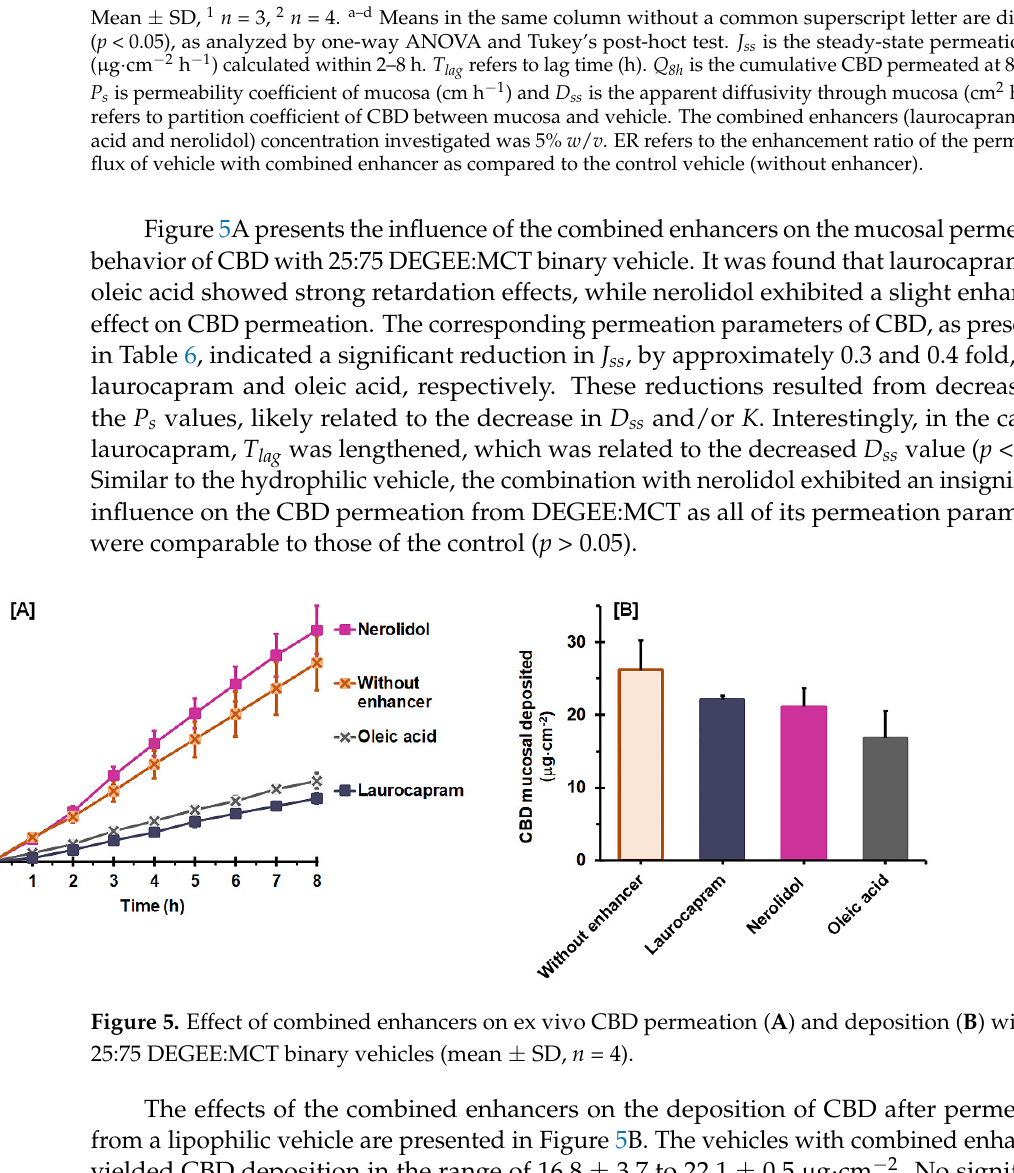
Table 6. Effect of combined enhancers on vehicle uptake capacity of mucosa and ex vivo permeation parameters of CBD with DEGEE:MCT system.